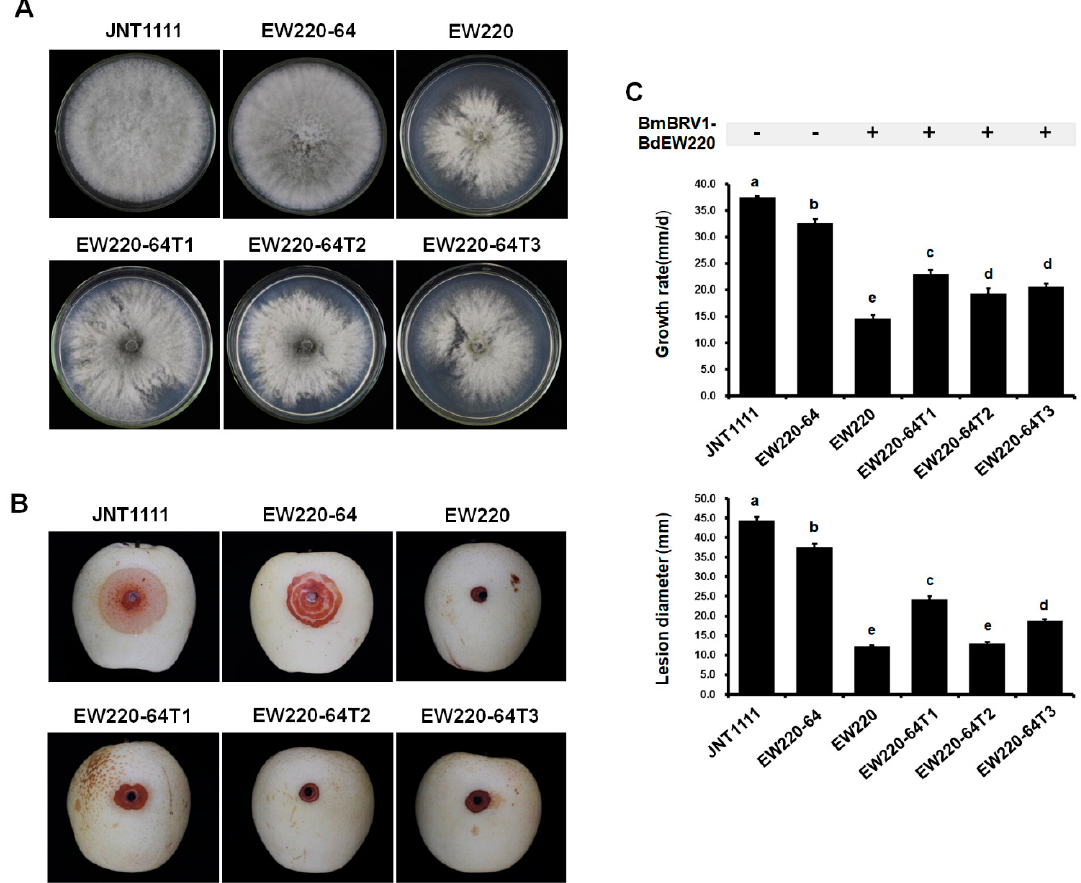
Figure 7. Colony morphology and virulence of strain EW220, strain JNT1111, and derived sub-strains on pear fruit ( P . bretschneideri cv. Huangguan). Strains EW220-64-T1, EW220-64-T2, and EW220-64-T3 were derived from EW220-64 in the pairing cultures of EW220/EW220-64. ( A ) Colony morphology in PDA medium (28 °C, 3 days); ( B ) pear fruits wound-inoculated with colonized plugs of tested strains and photographed at 4 dpi; ( C ) statistical analysis of the growth rate and the lesion size. The error bars indicate the standard deviations from different sample means. The letter indicates a significant difference at the p < 0.05 level of confidence based on a multiple range test.